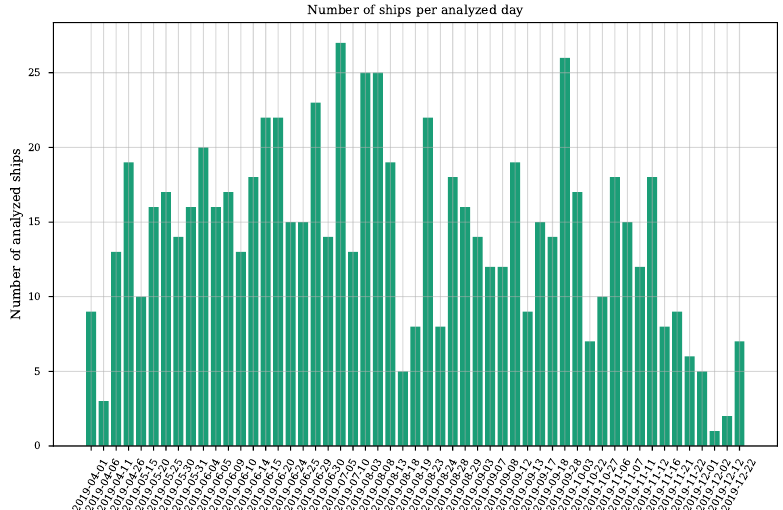
Figure 3. A list of days used for the dataset creation and the number of ships per day